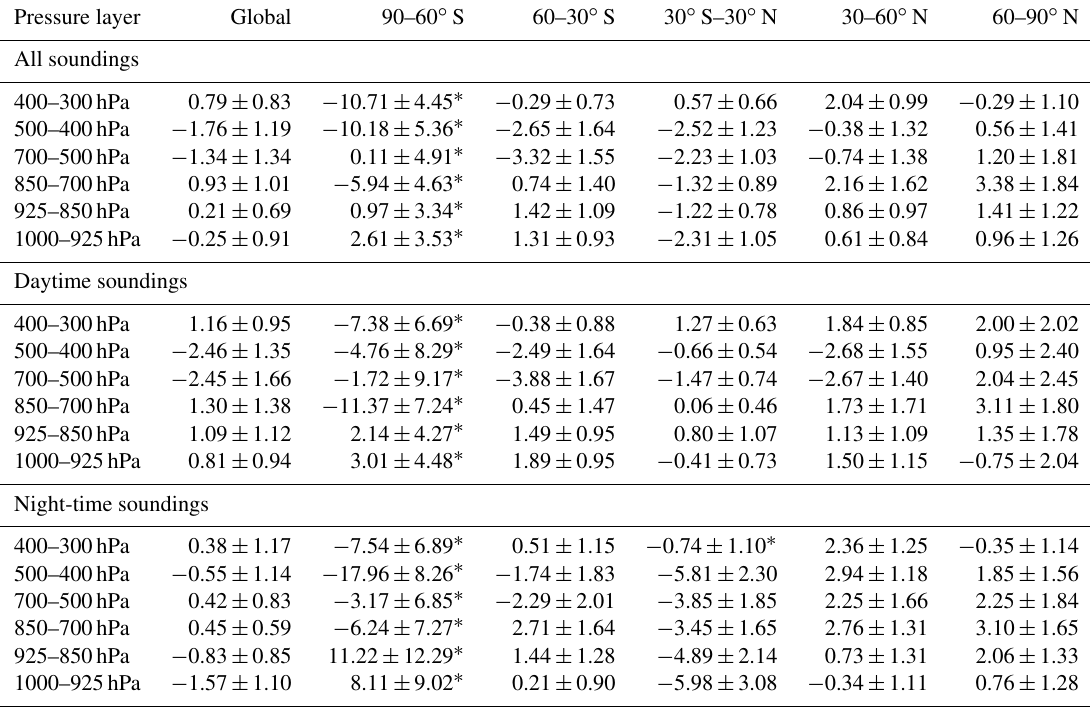
Table 3. Stability of IMS water vapour profile biases at ARSA sites, given as the trend in the bias (with units of %ppmv per decade). Trends are reported globally as well as five latitude broad bands for (i) all matches, (ii) daytime-only matches, and (iii) night-time-only matches. It should be noted that the separation between day and night cases is more representative of seasonal differences (e.g. polar winter/summer) than diurnal ones for high latitudes. Values denoted with ∗ are outside the 95% confidence